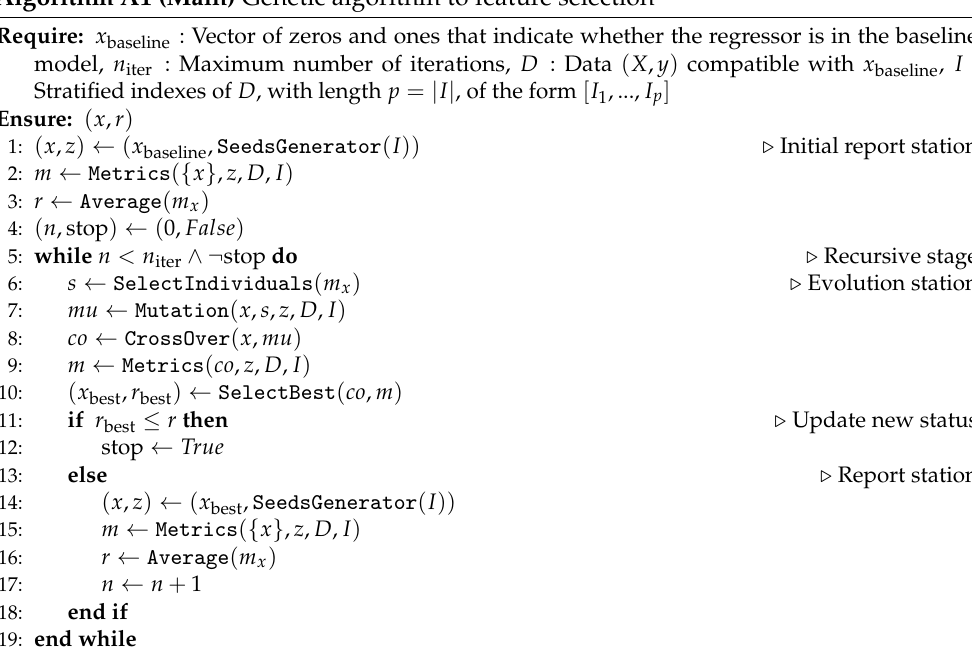
Algorithm A1 (Main) Genetic algorithm to feature